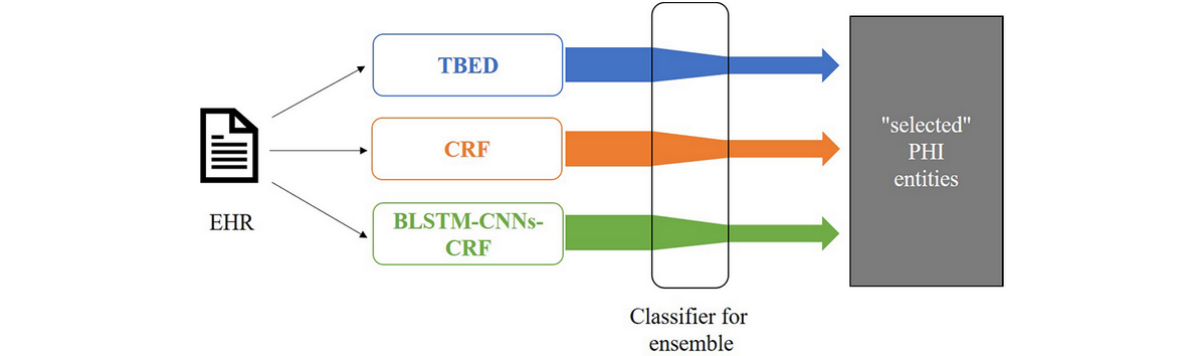
Figure 1. An overview of our deidentification system. BLSTM: bidirectional long short-term memory; CNN: convolutional neural network; CRF: